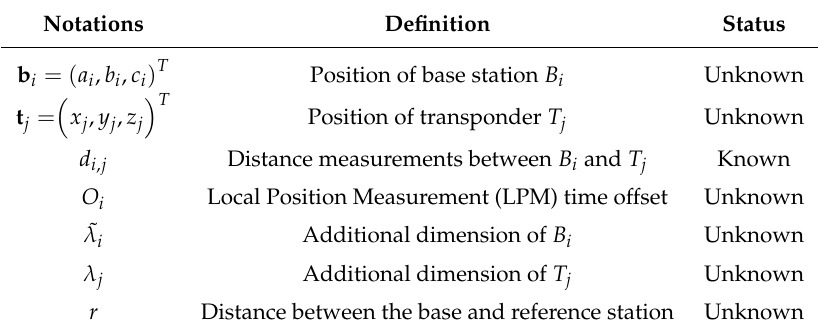
Table 2. Notations used in the